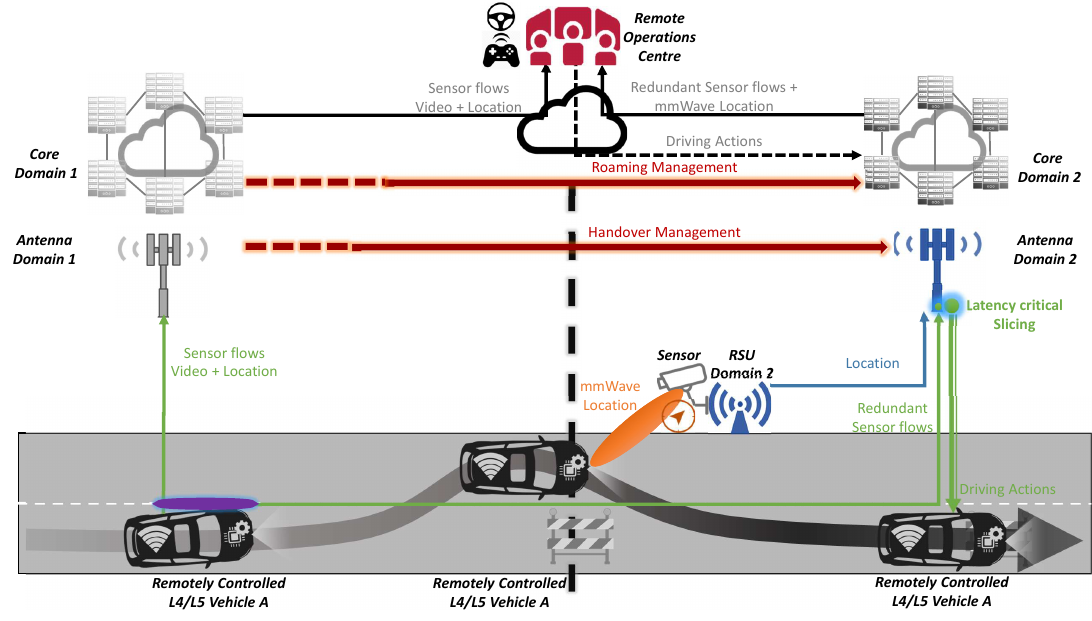
Figure 7. Remote driving scenario of the proposed